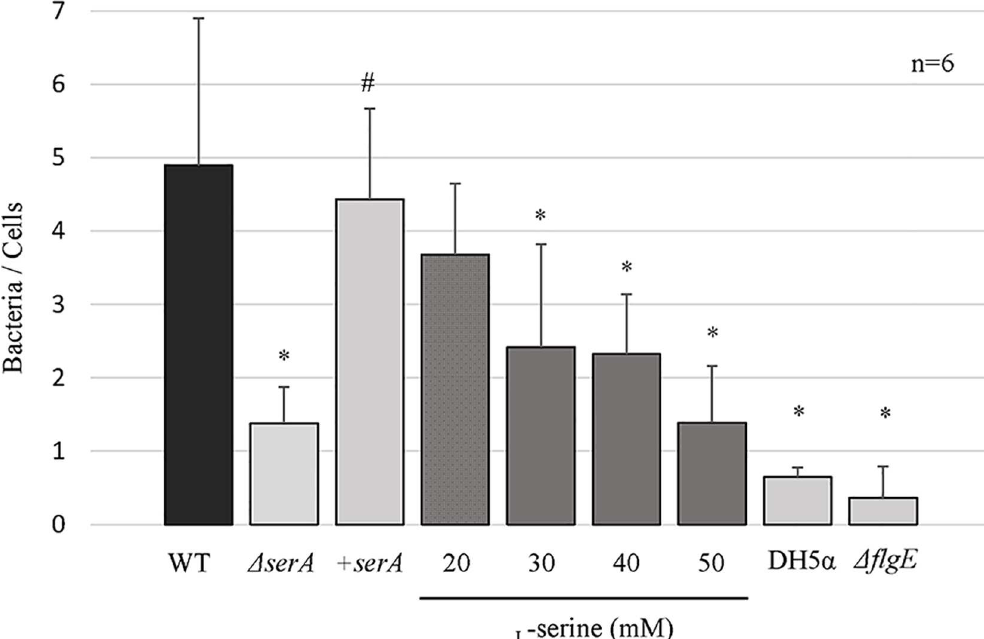
Fig 7. Bacterial adherence to Caco-2 cells for the wild-type strain (WT), PAO1Tn:: serA mutant ( Δ serA ), PAO1Tn:: serA (pUCP19- serA ) complementary strain (+ serA ), PAO1Tn:: flgE mutant ( Δ flgE ), E . coli DH5 α (as a negative control), and WT in the presenceof L -serine (20, 30, 40, and 50 mM). Bacterial adherencewas determined based on the numberof adheredbacteria per Caco-2 cell. The assay was performed in six replicates, and the results are expressedas the mean ± SD. Significant differenceswere observedbetweenWT and Δ serA ( * : P < 0.05), betweenWT and DH5 α ( * : P < 0.05), betweenWT and Δ flgE ( * : P < 0.05), betweenWT and WT in the